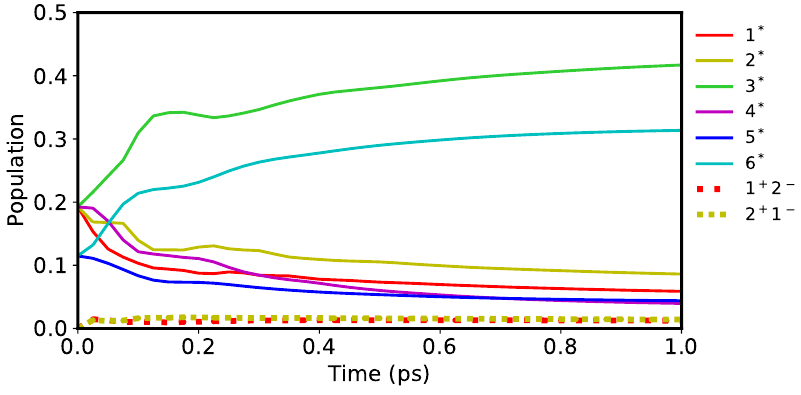
Figure 6. Population dynamics of FE and CT states at T = 77K. All of the levels shifts are set to zero, ∆ E m = 0 for m = 2, · · · ,6. All of the 36 states in Figure 5 are used for computation, but those of populations less than 0.01 are not